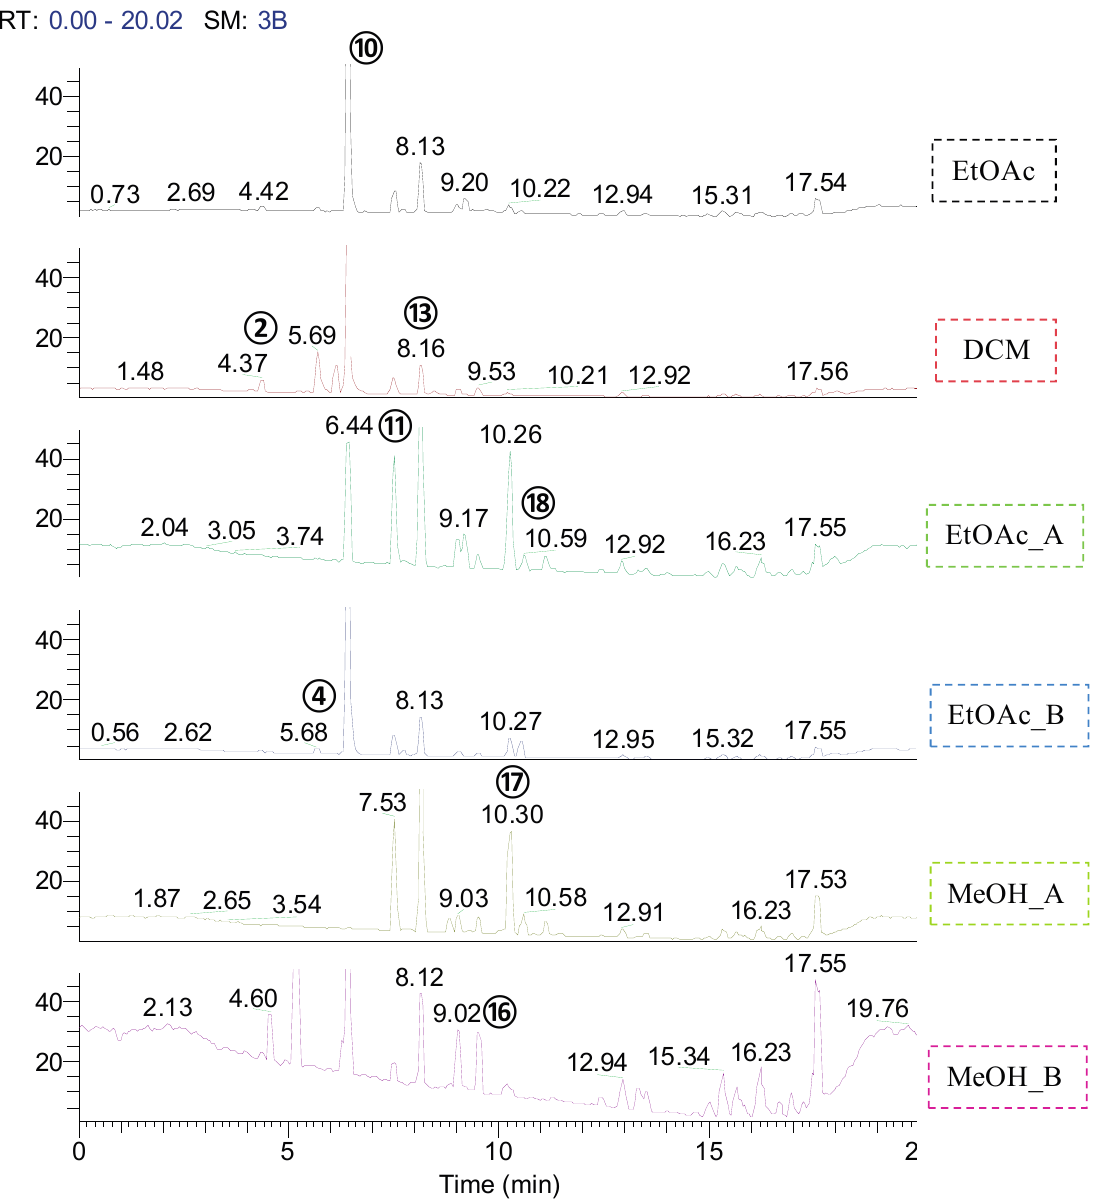
Figure 1. Base peak chromatograms of each extract obtained from M. falcatum in positive ionization